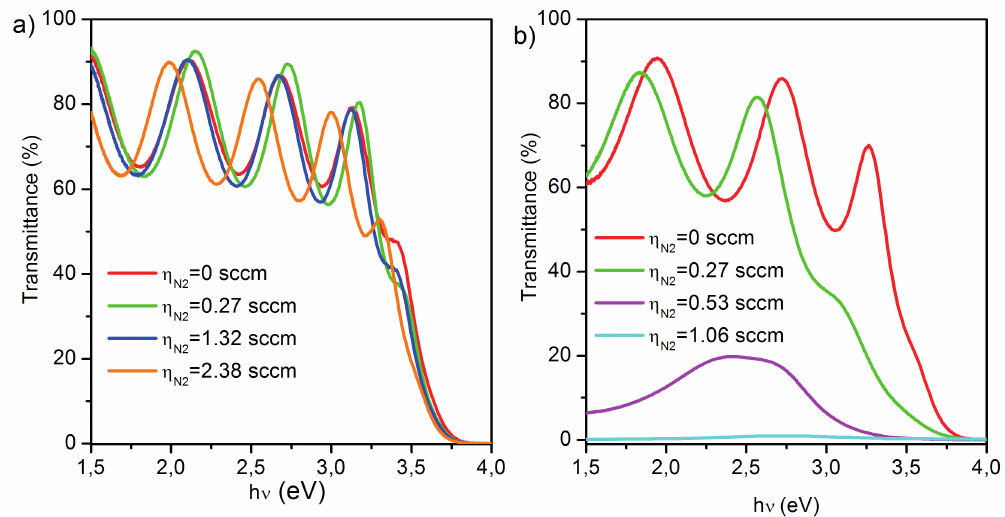
:N (I/I =0.13) and (b) non-stoichiometric TiO 2 0